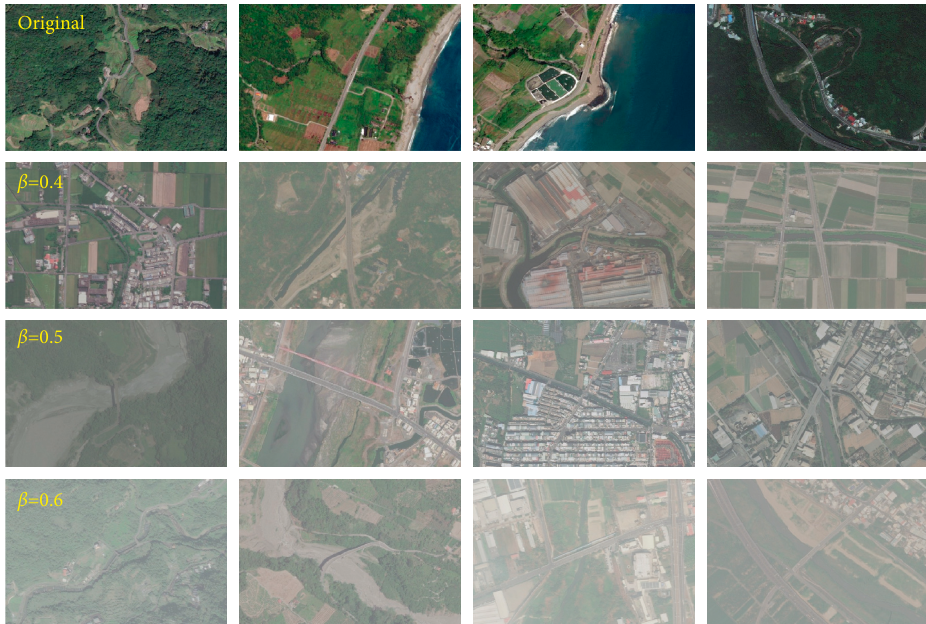
Figure 5: The displays of original images and their hazy versions. From top to bottom: original sharp images and hazy images with β � 0.3, β � 0.4, and β � 0.5, respectively. In particular, β denotes the scattering coefficient. In addition, the global airlight A is set to 0.7 in these images.